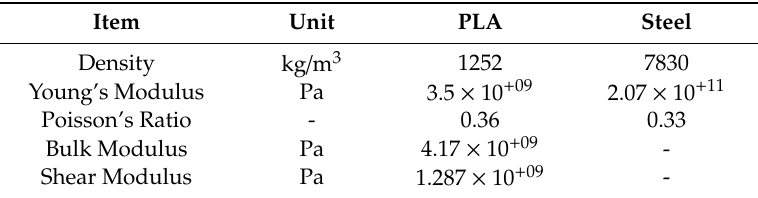
Table 1. Specification of polylactic acid (PLA) and